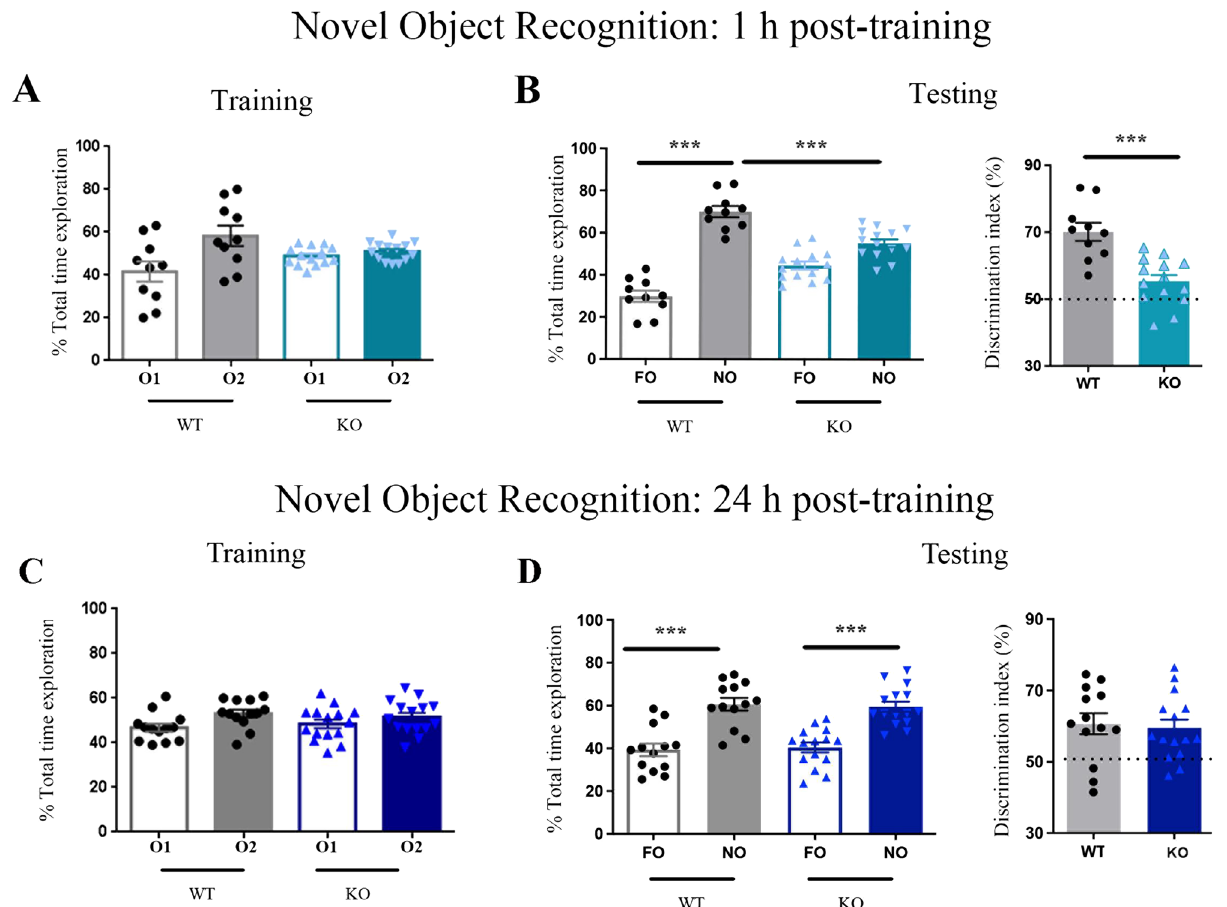
Figure 1. Fmr1 KO mice show a NOR impairment at 1 h, but not 24 h, training-to-test interval. ( A ) 1 h training: Wild-type (WT: grey bars) and Fmr1 KO (KO: blue bars) mice spend the same time exploring the identical objects (object O1, empty bars; object O2, solid bars); ( B ) 1 h testing: Left: WT mice explore the NO (grey solid bar) significantly more than the FO (grey empty bar) whereas KO mice do not show significant differences in the time spent exploring the familiar object (FO, empty light blue bar) and the novel object (NO, light blue solid bar). Right: The discrimination index, calculated as the time spent exploring the novel object divided by the total time spent exploring the two objects multiplied by 100, is significantly higher in WT mice (grey solid bar) than in KO mice (light blue solid bar). WT: n = 10; KO: n = 14. ( C ) 24 h training: Wild-type (WT: grey bars) and Fmr1 KO mice (KO: dark blue bars) spend the same time exploring the identical objects (object O1, empty bars; object O2, solid bars); ( D ) 24 h testing: Left: WT and KO mice spend more time exploring the novel object (NO, WT grey solid bar; KO, dark blue solid bar) than the familiar object (FO, WT grey empty bar; KO dark blue empty bar). Right: WT (grey solid bar) and KO (dark blue solid bar) mice exhibit a comparable object discrimination index. WT: n = 13; KO: n =